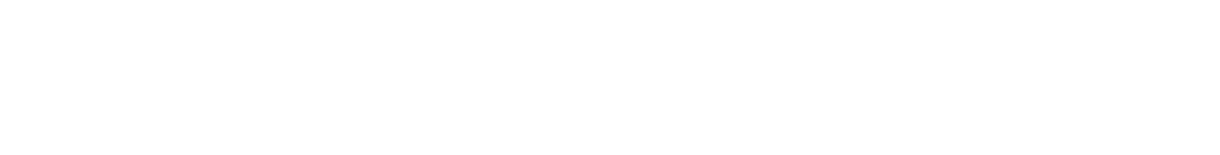
Frontiers in Environmental Science |